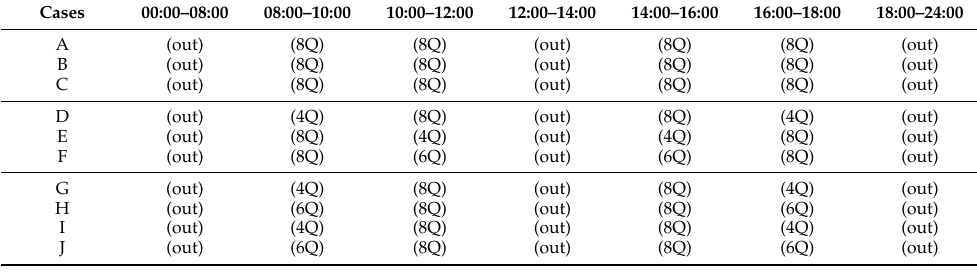
Table 1. Airflow rate used in each case studied.